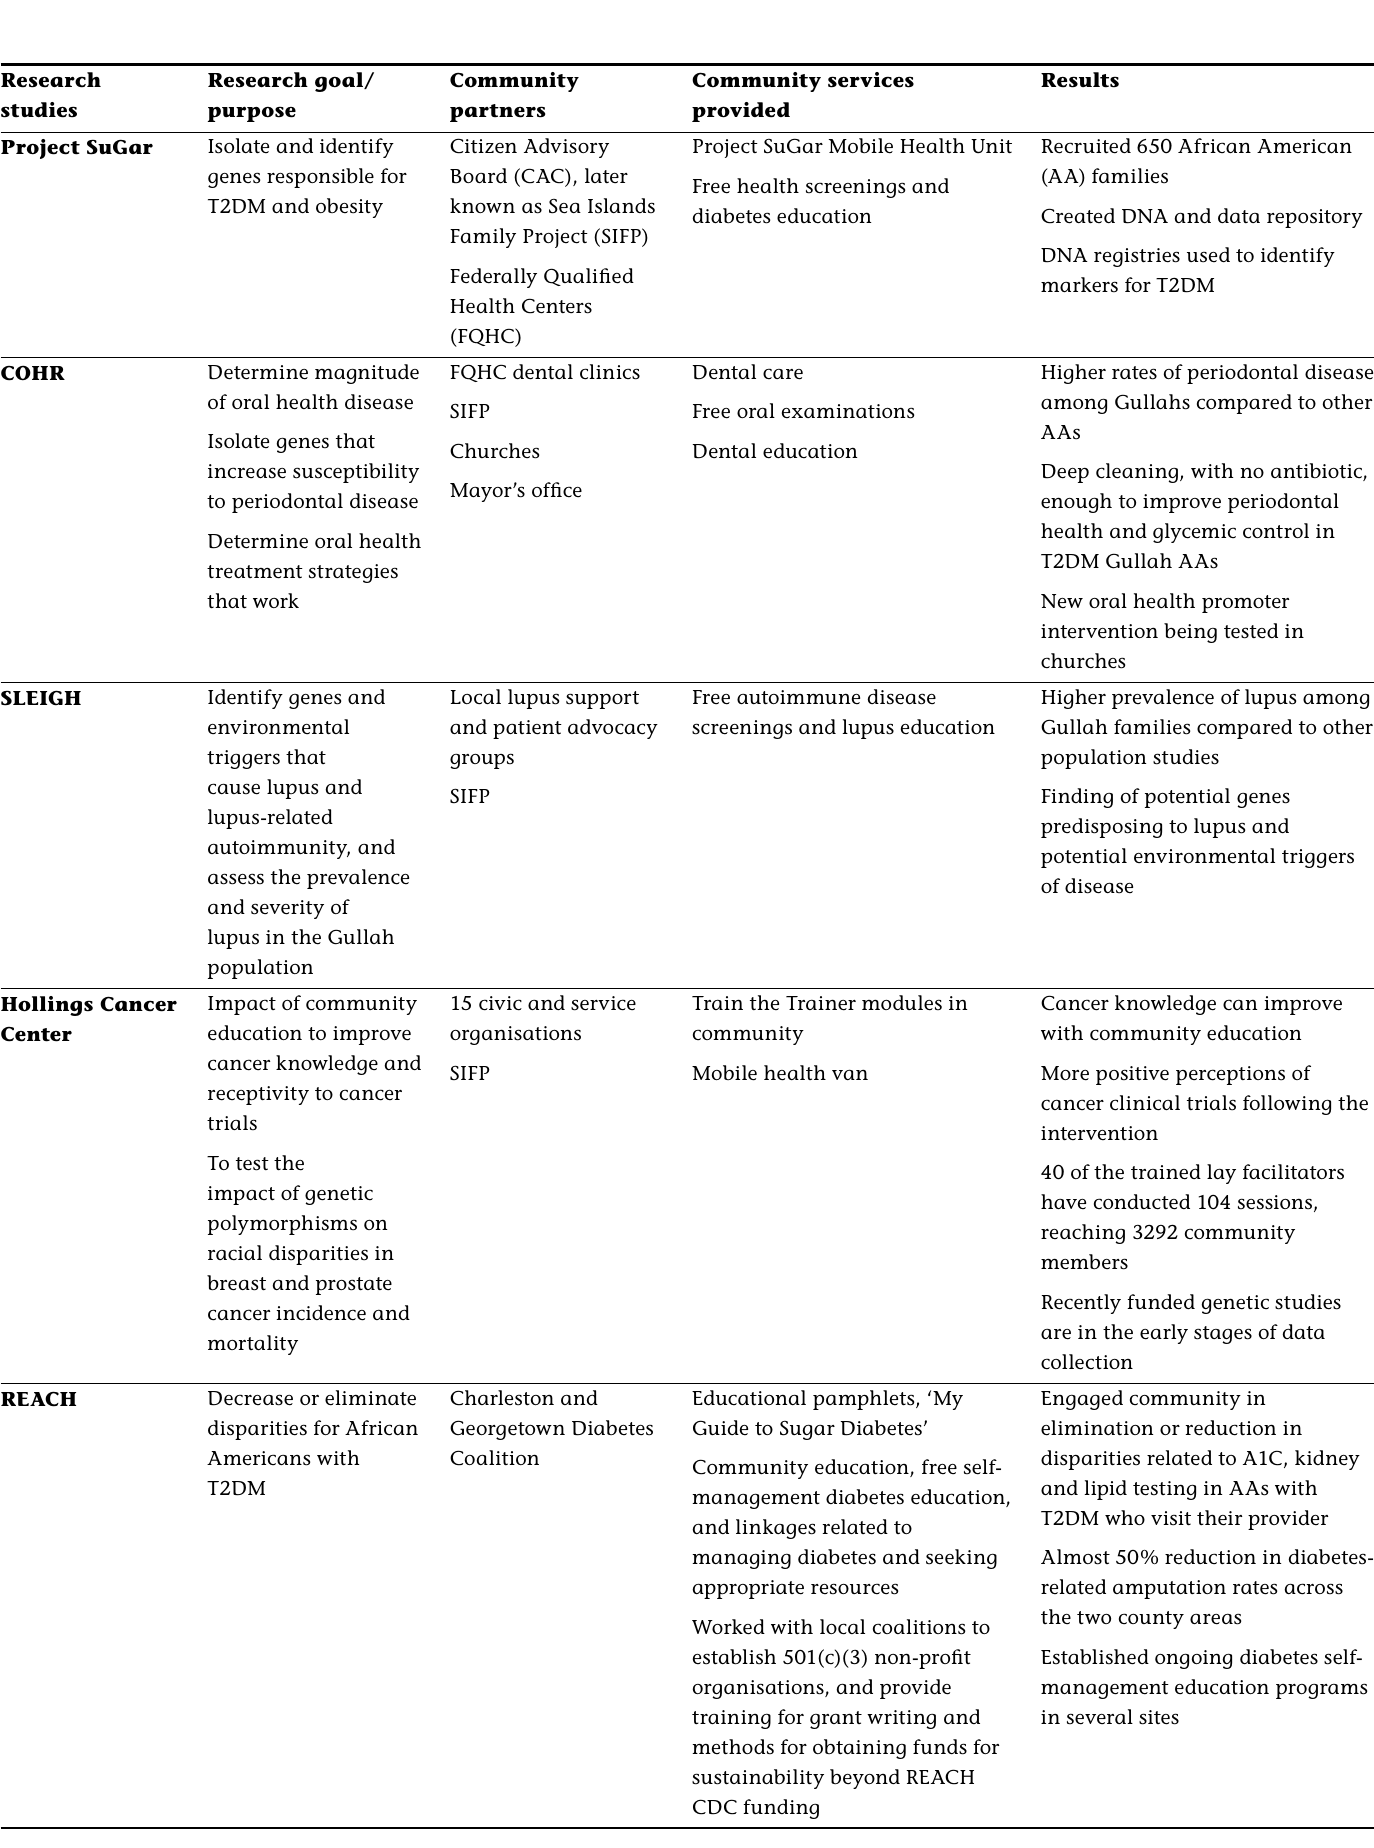
Table 1: Summary of community-engaged research with Sea Island